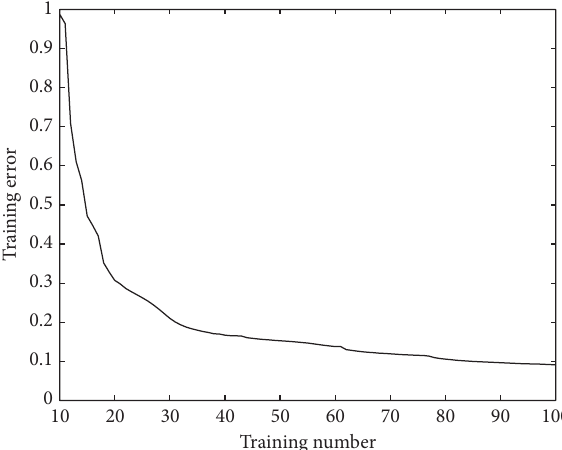
Figure 4: The LMA learning curve of the error function.